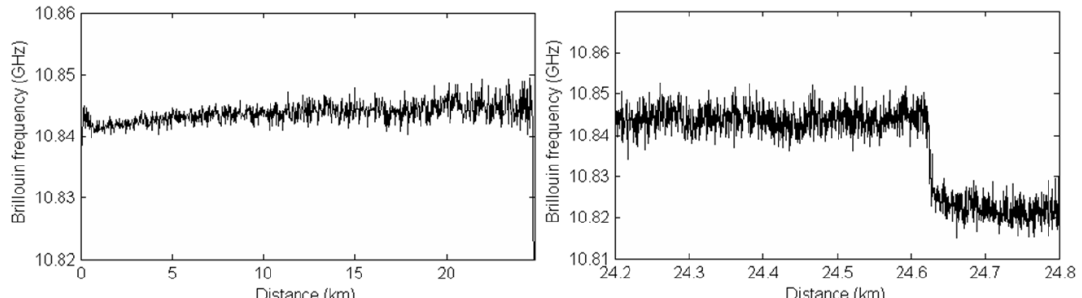
Figure 9. ( a ) Brillouin frequency shift along the sensing channel; ( b ) Detailed view of the 180 m long section at the end of the sensing